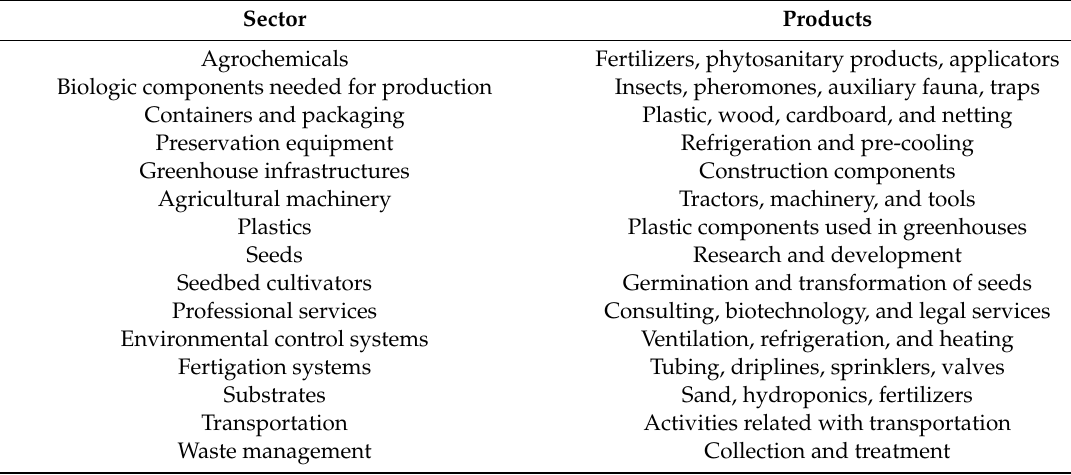
Table 1. Sectors of auxiliary